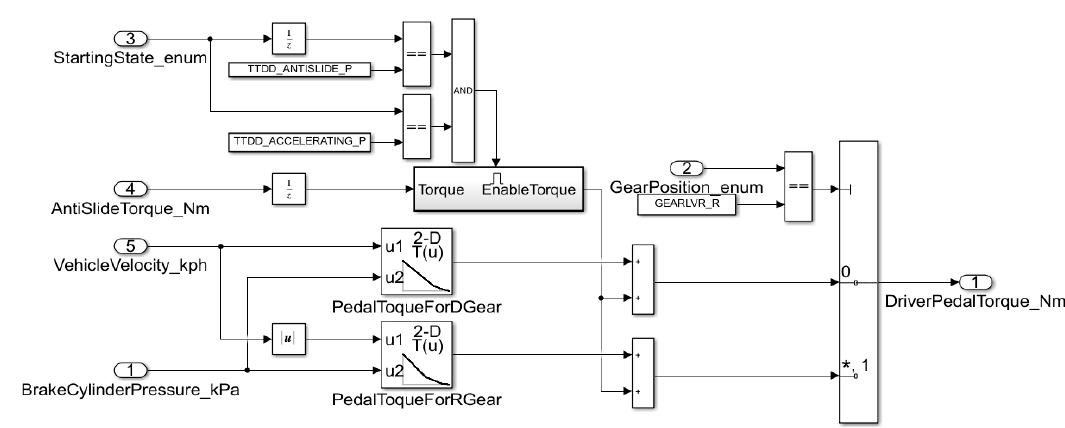
Figure 9. Pedal Control Torque Calculation Module.